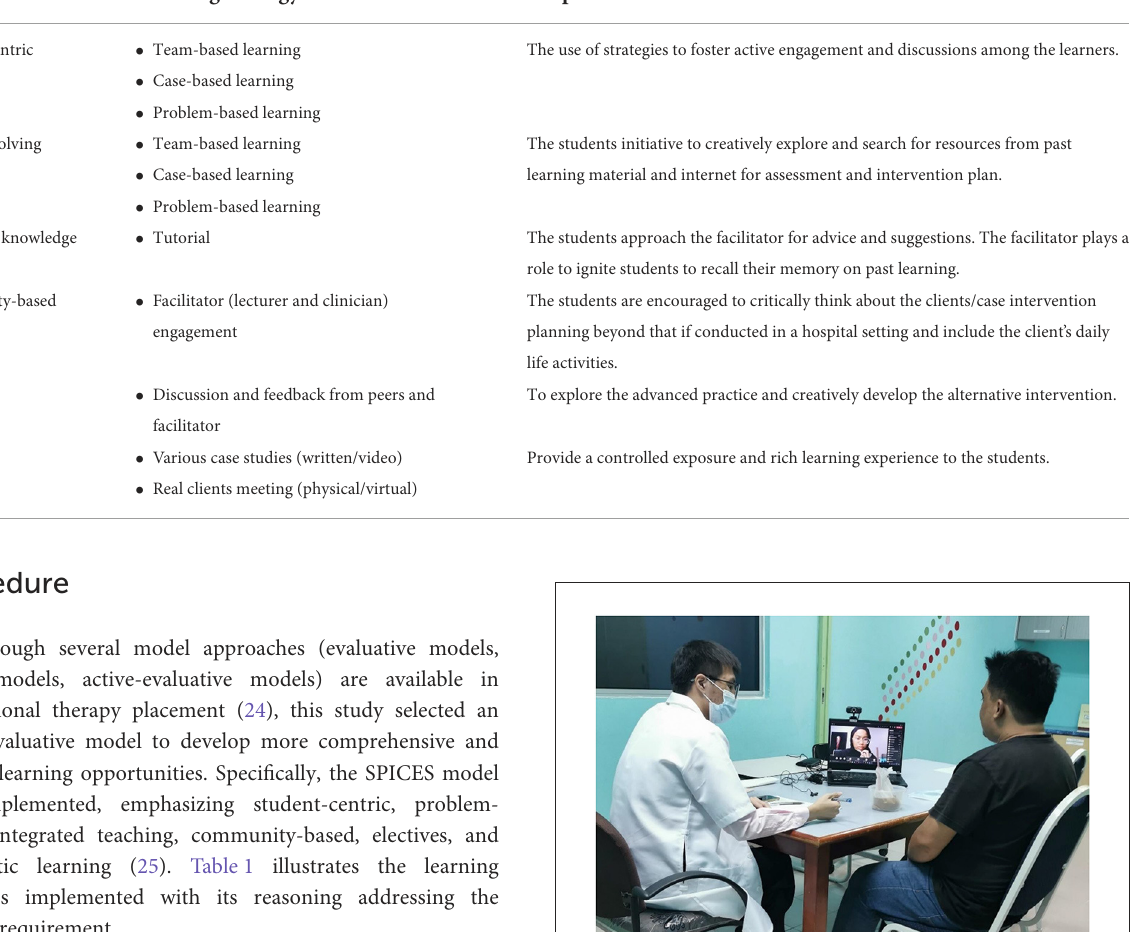
TABLE 1 The learning strategies implemented with its reasoning addressing the SPICES requirement. Spices